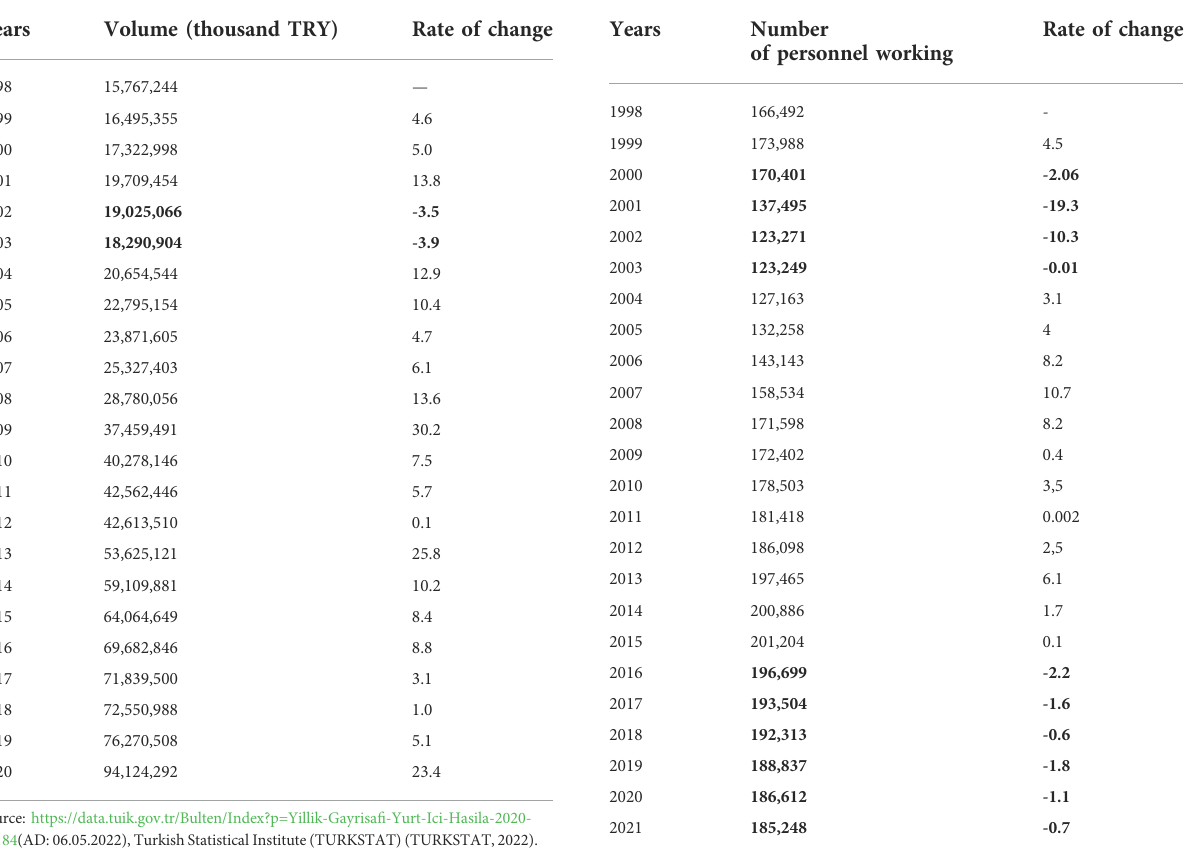
TABLE 3 Volume of the fi nance sector in GDP during 1998 – 2020. TABLE 4 Number of personnel working in banks during 1998 –